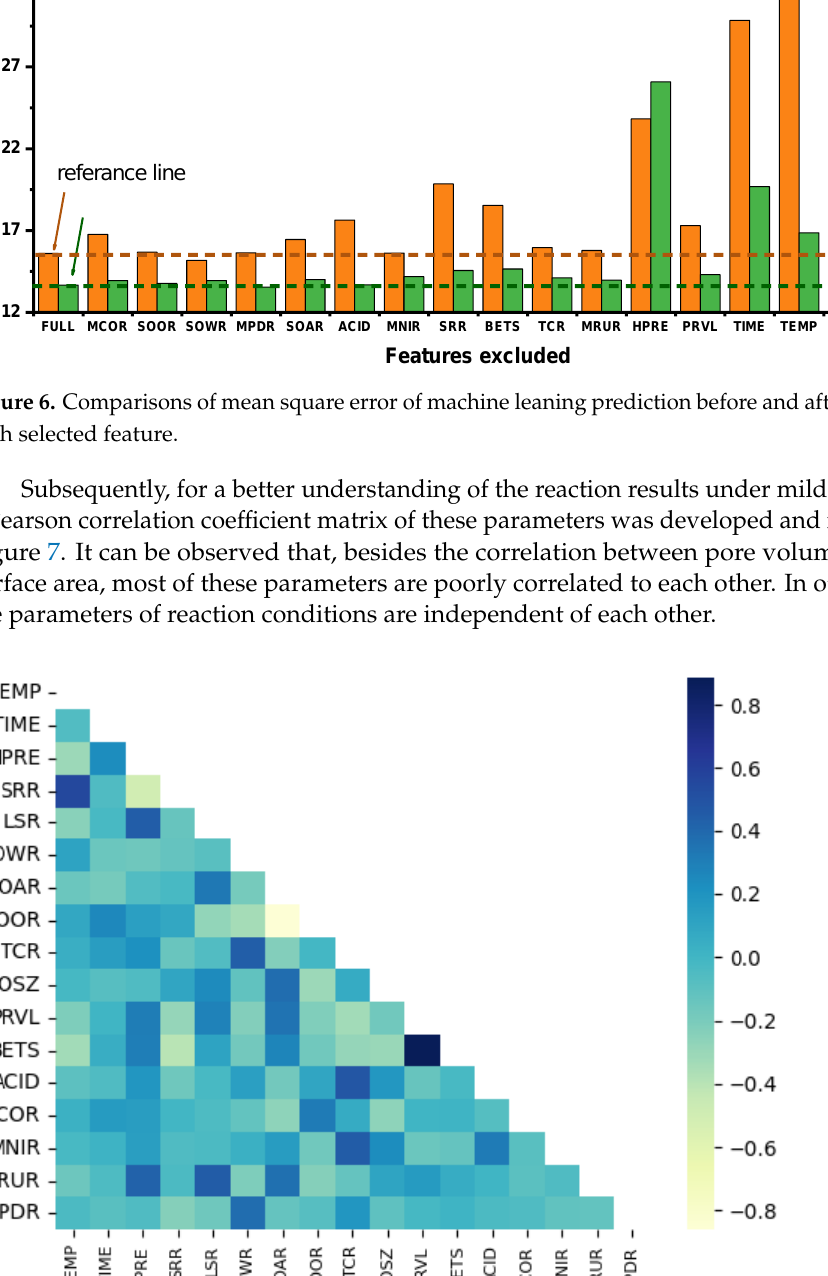
Figure 5. SHAP value (a) and feature importance (b) of XgBoost prediction on aromatics.